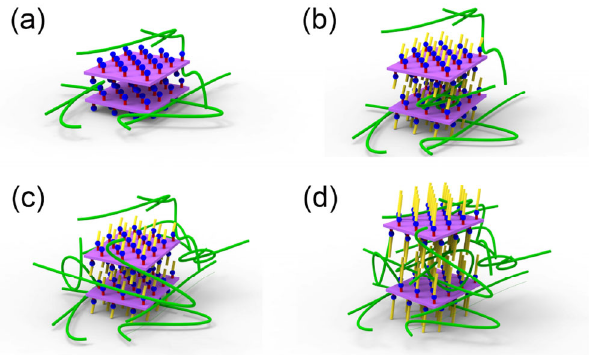
Fig. 7 Schematics of dispersion of (a) pristine  -ZrP, (b) HA_  -ZrP, (c) DGA_  -ZrP, and (d) OA_  -ZrP nanosheets in mineral oil.